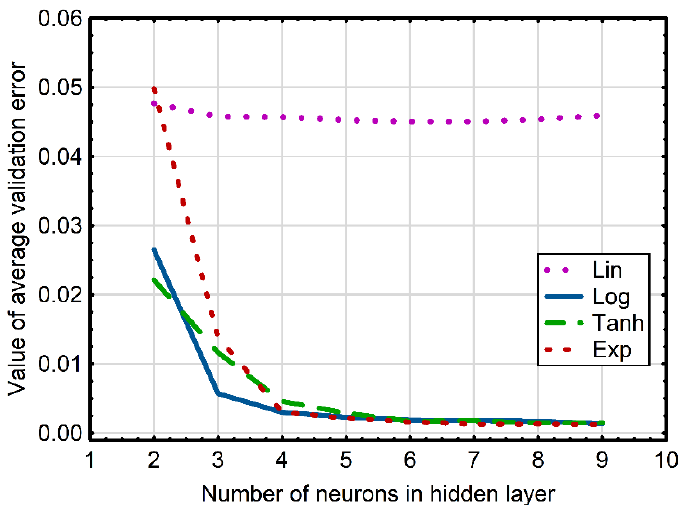
Figure 6. The impact of the number of nodes and the type of activation function (linear (Lin), logistic (Log), exponential (Exp) and hyperbolic tangent (Tanh)) in neurons of the hidden layer on the average value of the learning, test and validation errors of the examined networks describing levels of acetone and ethanol in analyzed mixtures.